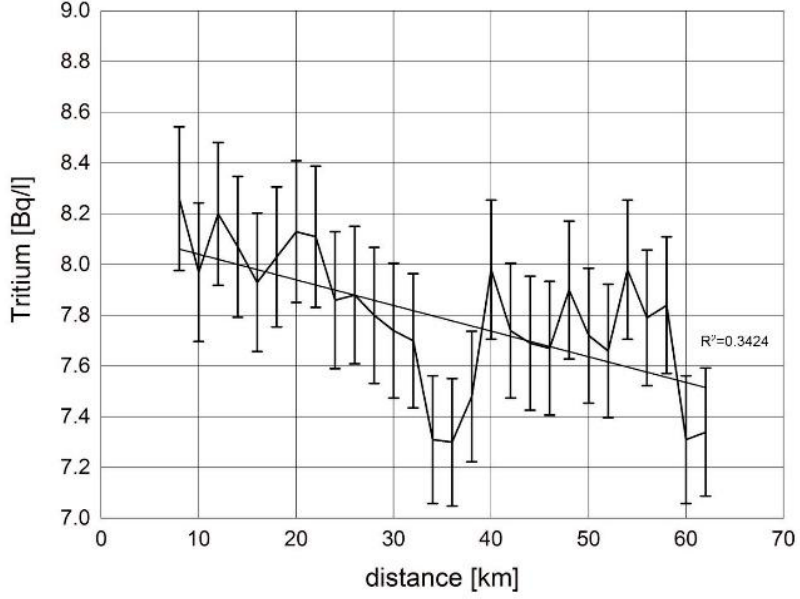
Figure 13. Tritium [Bq / l] in the river water between Schmilka (km 0) and Pieschen (km 60) during the first (August 2018) survey. The displayed uncertainties reflect both counting statistics and sample preparation errors.